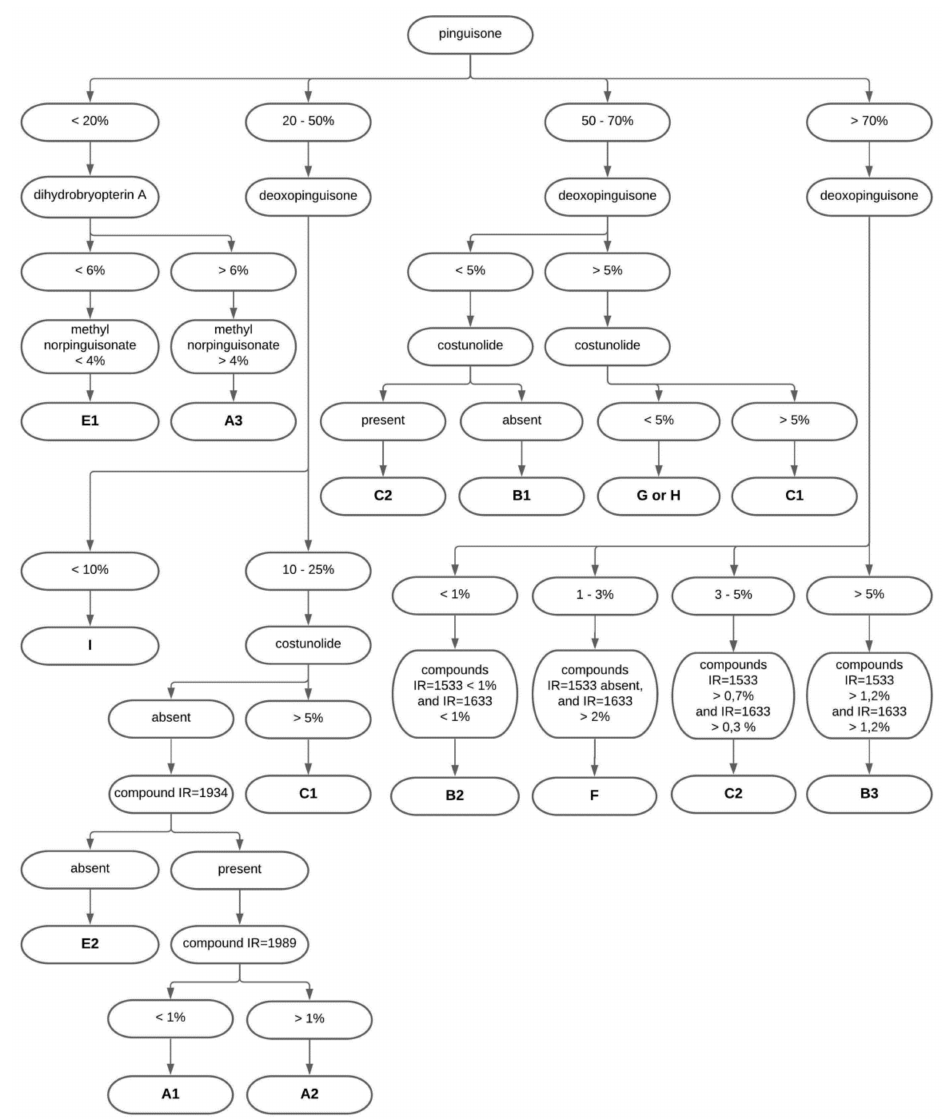
Figure 4. Guide for the identification of cryptic species and genetic lineages of A. pinguis based on the content of marker